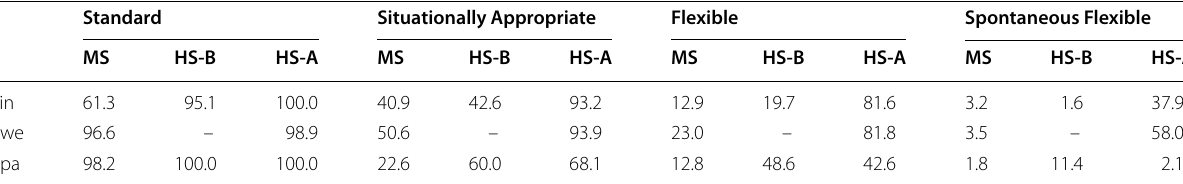
Swedish HS-B (basic track high school) students are not included because of the small sample size MS middle school; HS high school; HS-A advanced mathematics track high school; HS-B basic track high school; Fin Finland; Swe Sweden; Spa